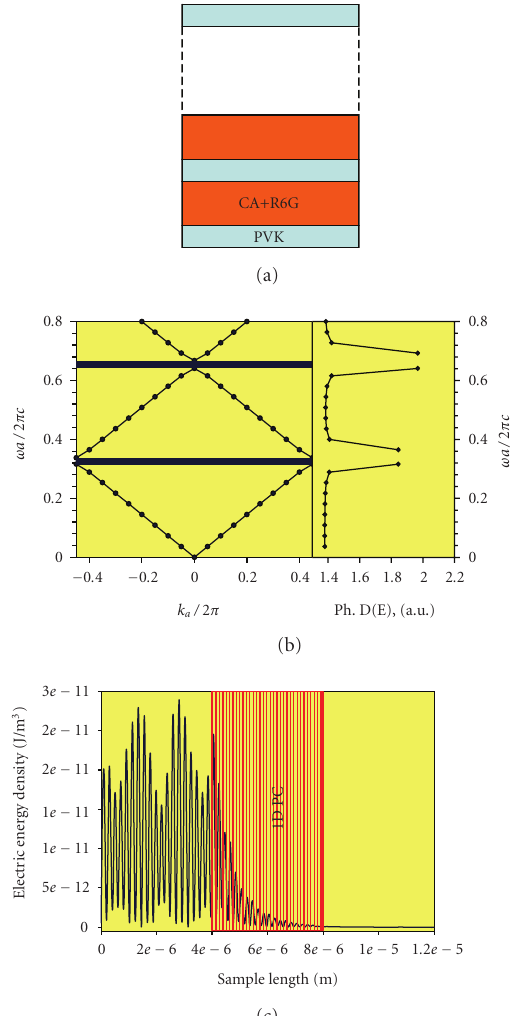
Figure 1: (a) Dye-doped 1D PC, (b) dispersion relation of the 1D PC (with an infinite number of layer) with MIT photonic band gap, and (c) propagation of an e.m. wave ( λ = 600 nm) through a 39- layers 1D